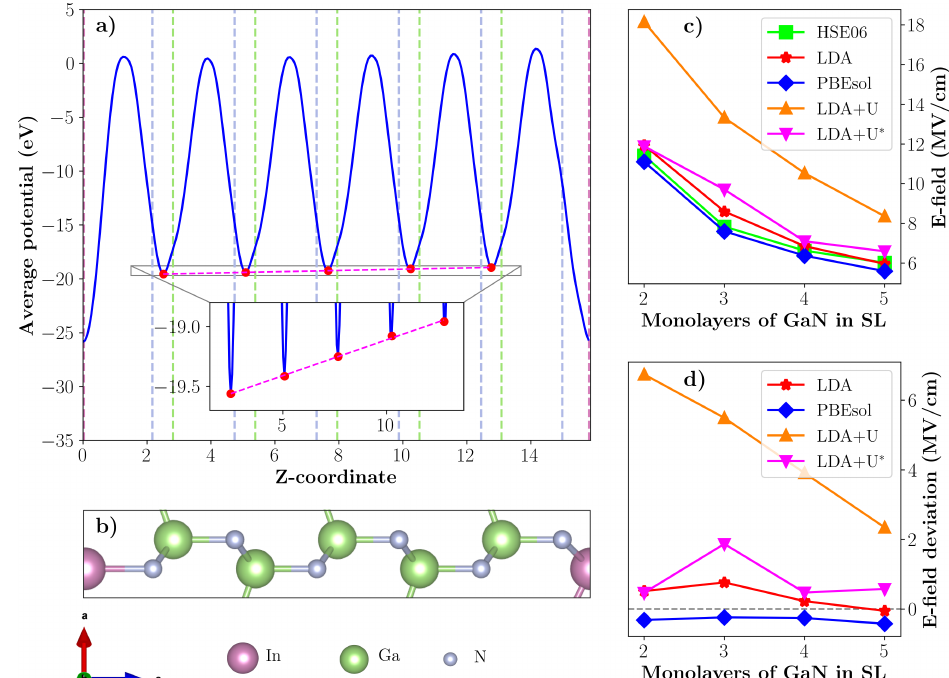
Figure 7. E-fields in the InGaN superlattices made of 1 ML of InN and 2 to 5 ML of GaN: ( a ) Average potential along the c-axis in (1:5) SL; ( b ) The structure of the corresponding SL; ( c ) E-fields computed for a series of superlattices with 2 to 5 ML of GaN, evaluated using HSE06, LDA, PBEsol, LDA+U with U parameters taken from [14] and this work (U ∗ ); ( d ) Deviation of the E-fields from the HSE06 values. The dashed lines in ( a ) indicate the atomic position shown in ( b